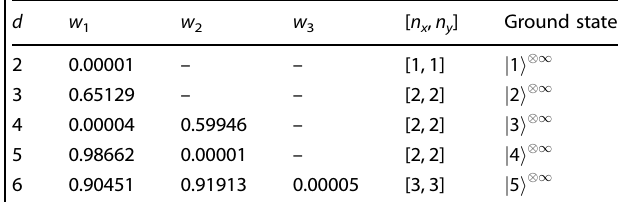
Table 2. Ground states and parameters of H 222 with d -dimensional local observables achieving the classical bound −